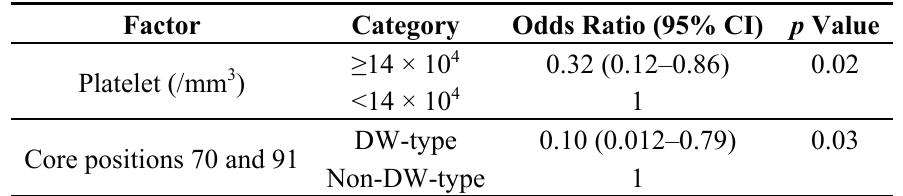
Table 3. Factors associated with virological non-response (NR) in this study identified by multivariate